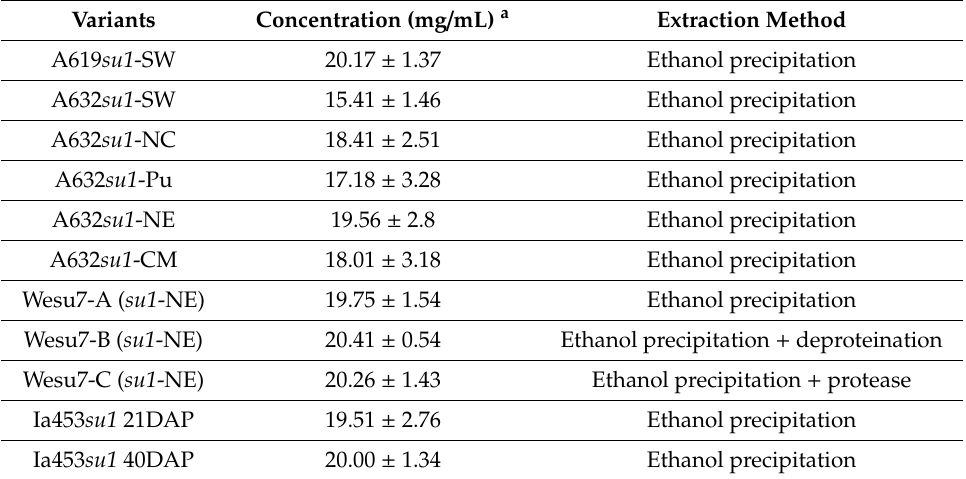
Table 1. Solubility of phytoglycogen extracts in 1 × phosphate-bu ff ered